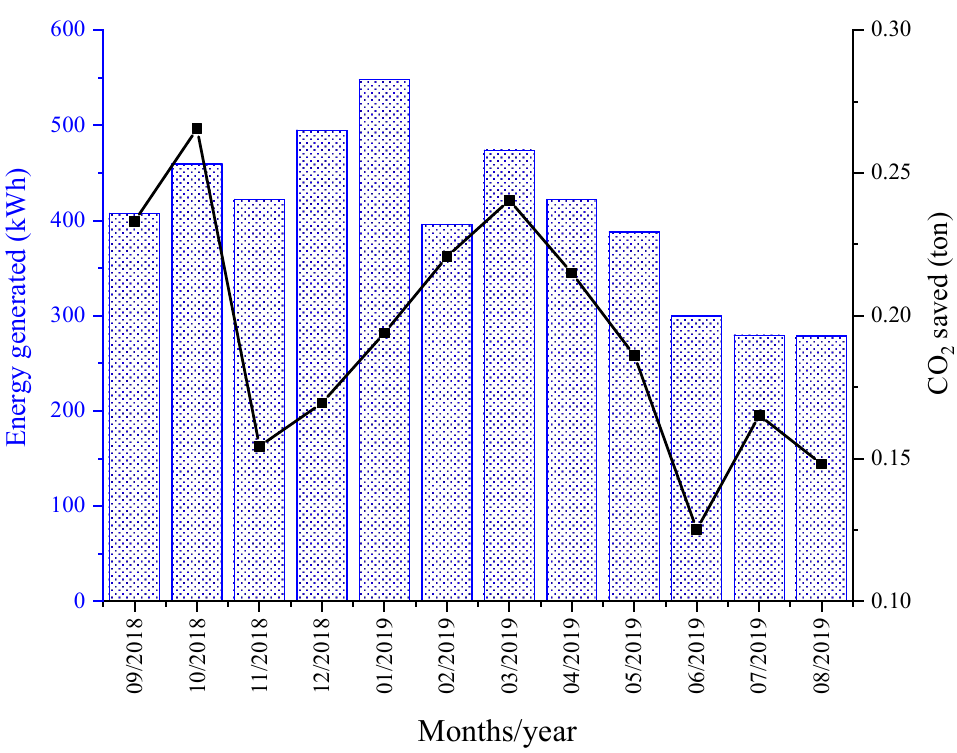
Figure 7. Total monthly electric production by the photovoltaic panels and amount of CO 2 not emitted to the atmosphere.